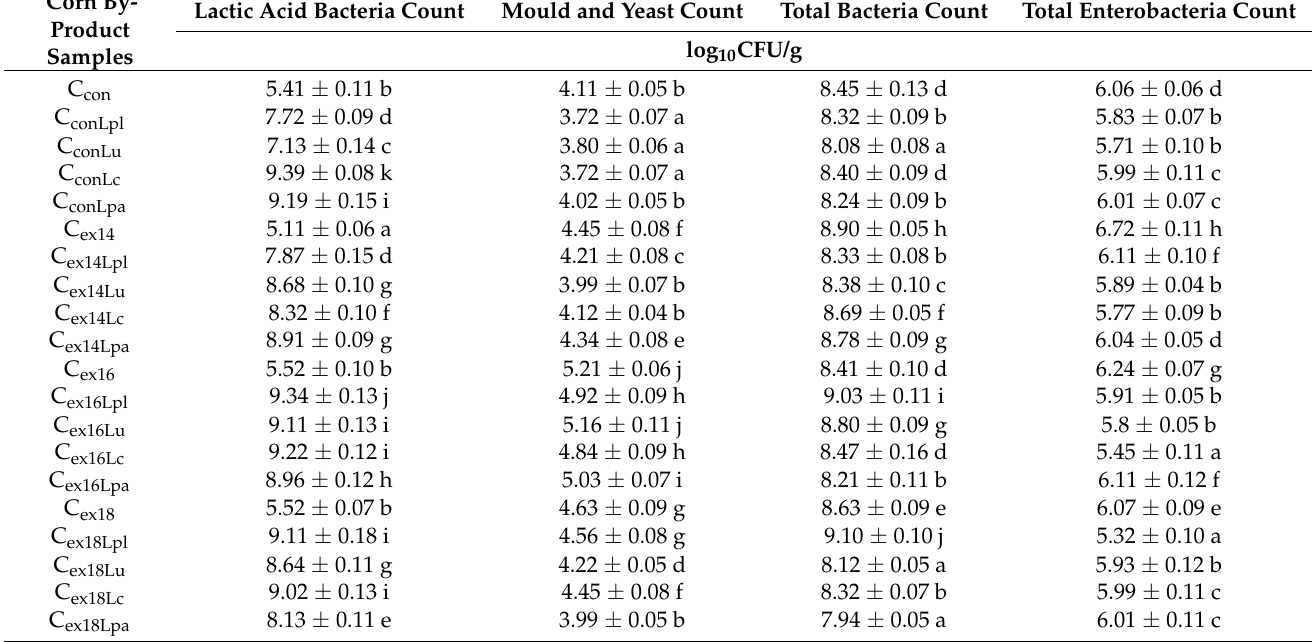
Table 2. Microbiological parameters of the corn